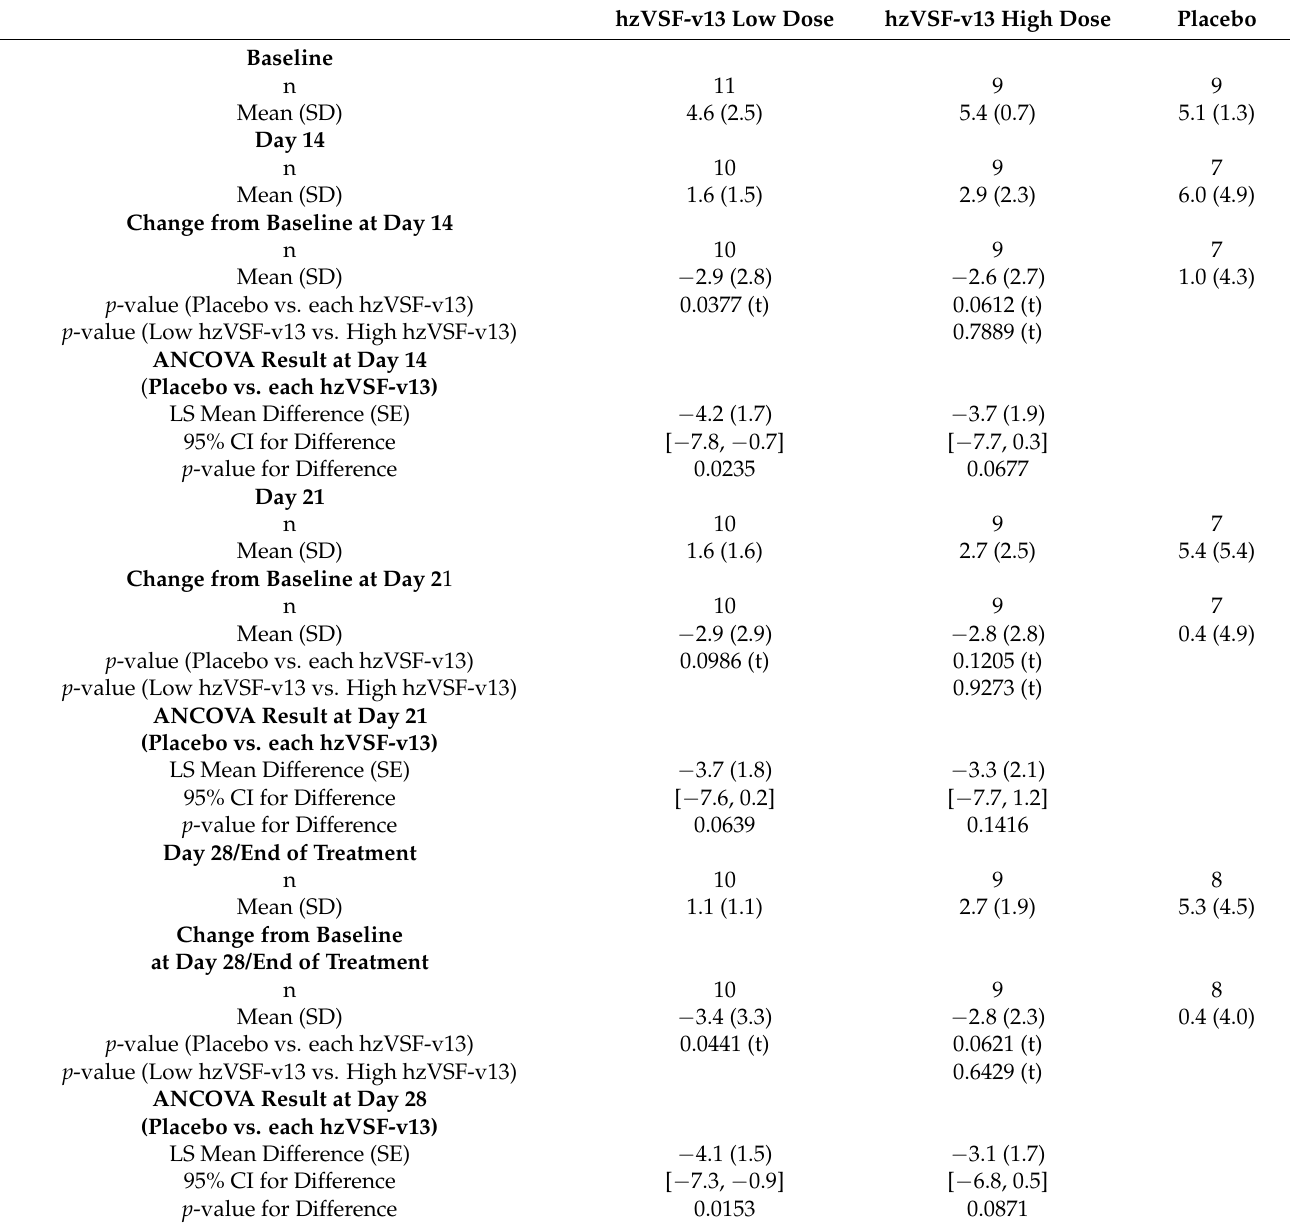
Table 8. Changes from baseline in NEWS2 score in the severe stratum ((t) = t